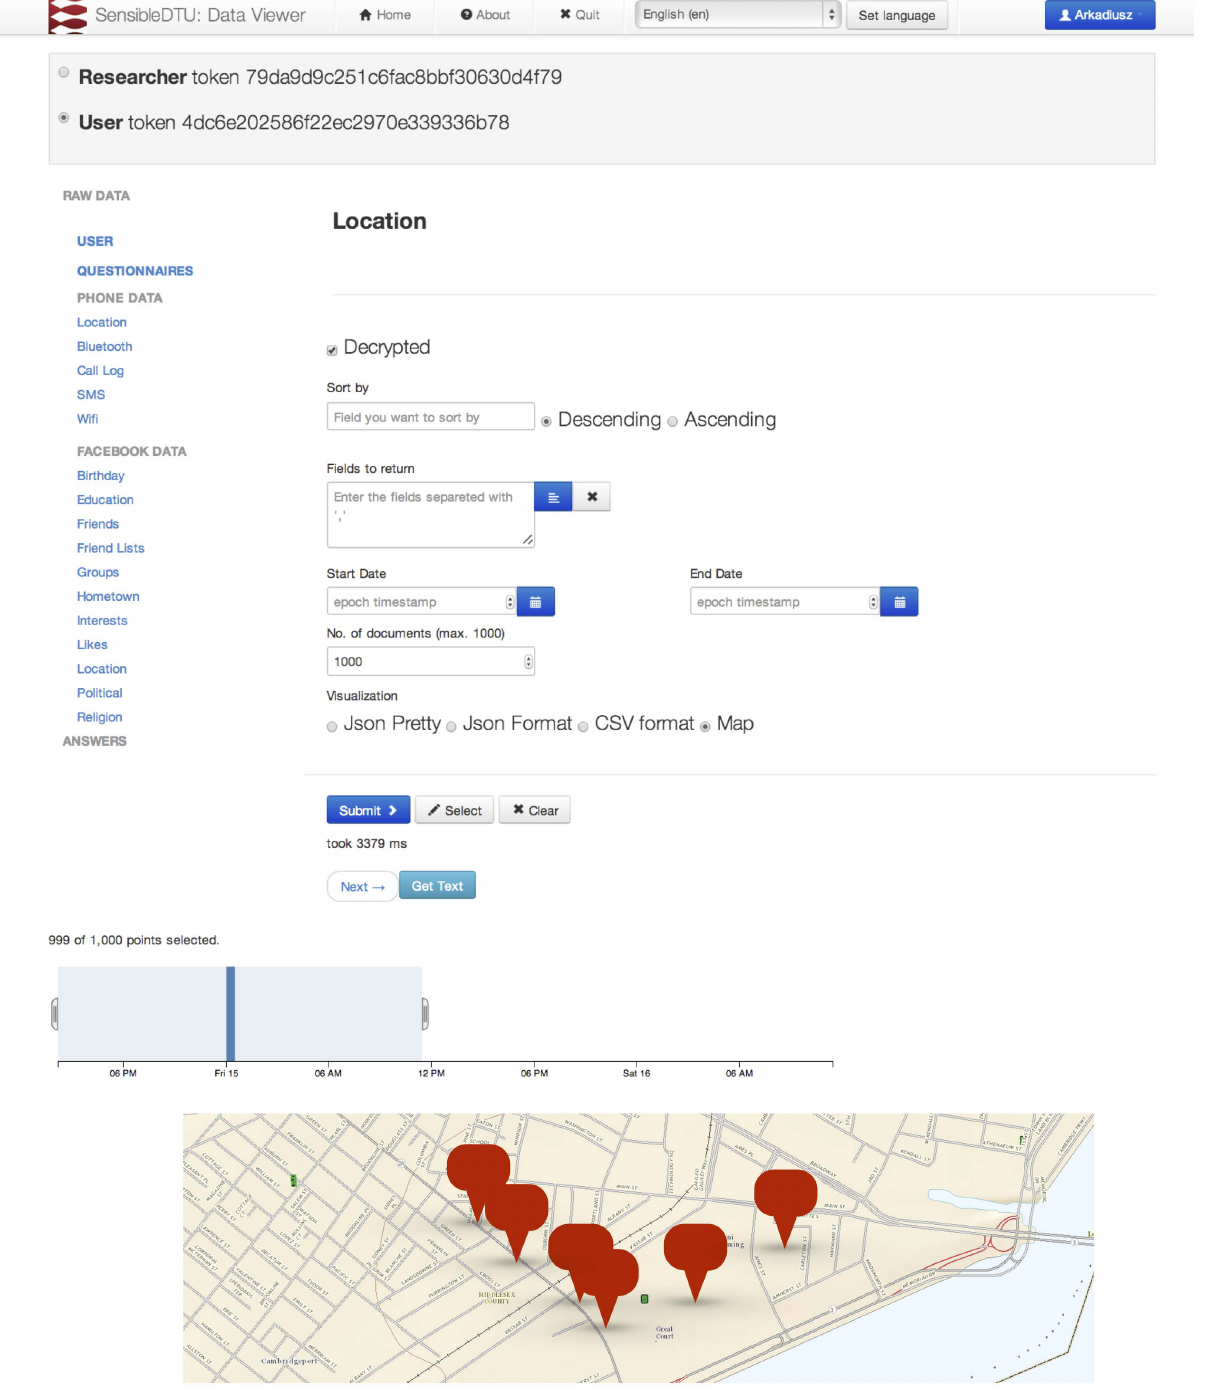
primarily of very short range—between 5 and 10 m ( 16 { 33 feet)—detection of the devices of other participants (set in ‘visible’ Þ , denoting that device i has observed device j at time t with signal strength s .